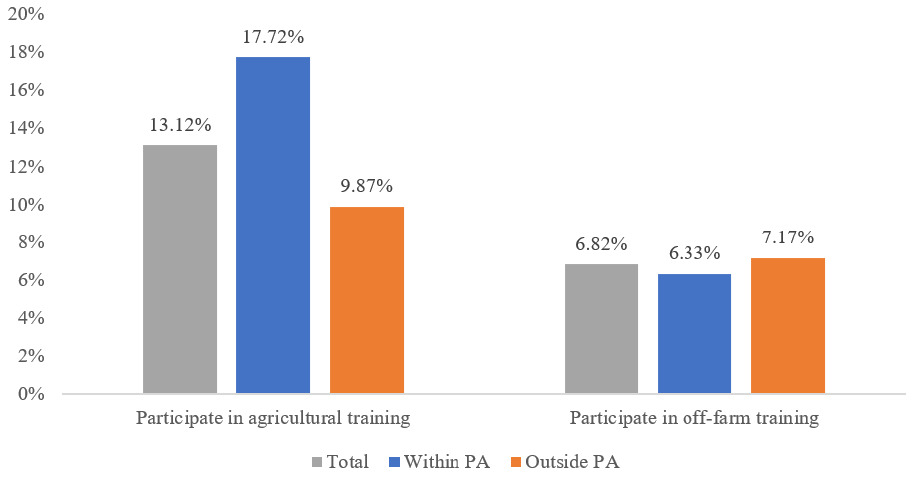
Figure 3. Proportion of households participating in skill training (%). There was no significant difference in per capita income between the households within and outside PAs, but the compositions of their income differed (Figure 4). The av- erage per capita income of households around the PAs was 21,117 CNY in 2018, which was higher than the national level of 14,617 CNY in the same year [61]. The average per capita income of the households within PAs was 20,065 CNY, slightly lower than that outside PA. However, the gap was not significant even at a 10% confidence level. Chinese household income usually encompasses five sources, including wage income, operating income, property income, transfer income, and other income. Operating income includes agricultural income and off-farm income. The main source of wage income comes from the non-agricultural sector. Transfer income mainly refers to government subsidies and the value of social or private donations received by families [62,63]. With the expansion of off-farm employment in rural households, off-farm earnings became the primary source of household income around PAs, which is similar to other areas in China [61]. Although off-farm earnings were the leading source of household income, their propor- tions in the household income differed between the households within and outside PAs. The proportion of off-farm income in the household income was 24.4% for the households within PAs which was 14 percentage points less than those outside PAs.